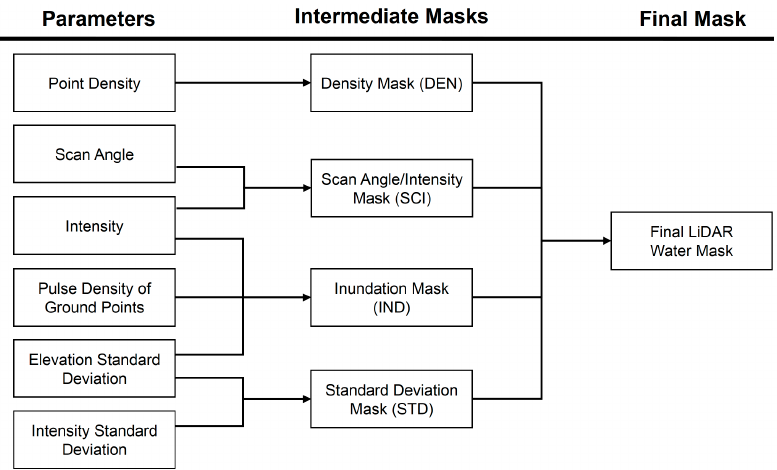
Figure 5. Flow chart illustrating the tiered decision tree methodology used for classifying water using LiDAR data.